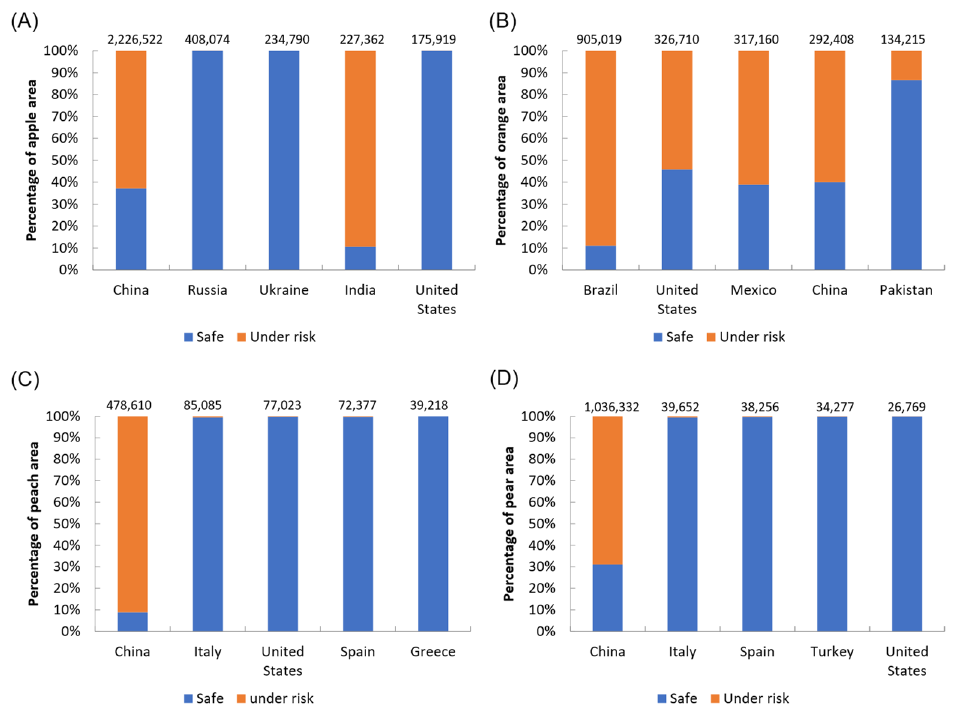
Figure 4. Based on the current potential seasonal distribution, percentage of safe and risk areas in terms of attack by B. dorsalis for four important fruit species: ( A ) apple; ( B ) orange; ( C ) peach; ( D ) pear. The number on each bar refers to the harvested area (hectare). Countries in each plot are ordered according to the harvested area, from largest to smallest.